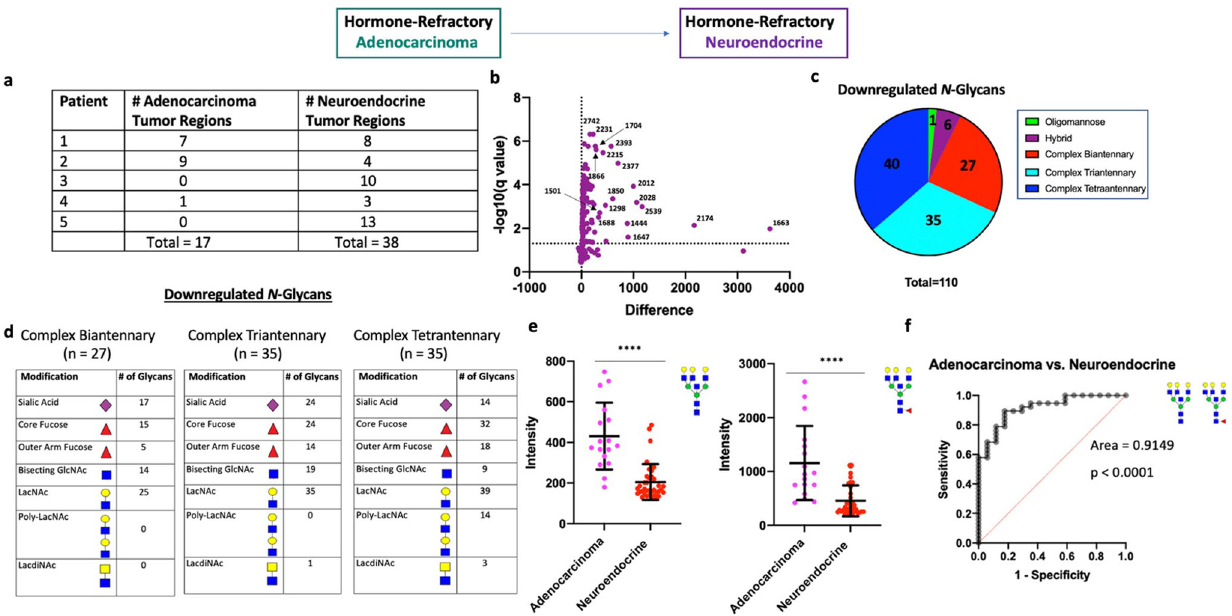
Fig. 8 N-linked glycosylation changes associated with neuroendocrine differentiation. a Table demonstrating number of annotated adenocarcinoma and NE tumor regions for each patient. b Volcano plot comparison of all glycans in annotated adenocarcinoma regions ( n = 17) and annotated NE tumor regions ( n = 38). 110/150 glycans detected demonstrate statistical signi fi cance between the two groups with all structures downregulated. c Circle graph demonstrating the proportion of downregulated glycans within each major structural category. The vast majority of downregulated glycans were complex-type with roughly equal proportions of complex bi-, tri-, and tetraantennary structures. d Table demonstrating common structural modi fi cations associated with the downregulated N -glycans in each major structural class showing a signi fi cant change. e Scatter plot comparison of fucosylated and non-fucosylated Gal3Man3GlcNAc6 between all adenocarcinoma ( n = 17) and NE ( n = 38) tumor regions. Statistics performed between each group by multiple, unpaired t test with p < 0.05 considered signi fi cant. The following system was used to denote signi fi cance: p < 0.05 (*), p < 0.01 (**), p < 0.0001 (***), p < 0.00001 (****). Error bars correspond to standard deviation. f ROC curve demonstrating the predictive power (AUC = 0.9149, p < 0.0001) of fucosylated and non- fucosylated Gal3Man3GlcNAc6 for predicting NE